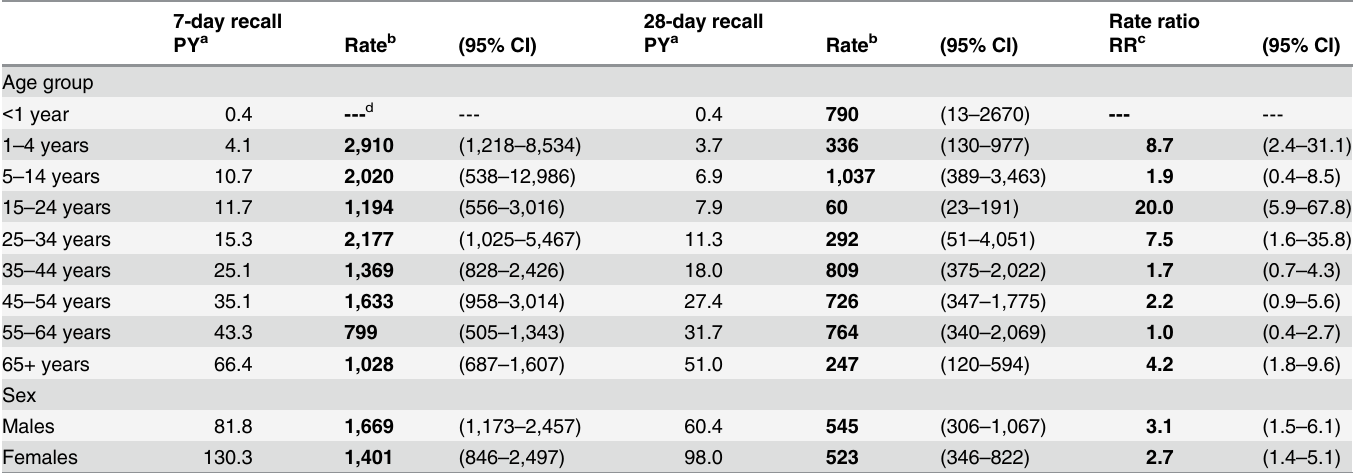
Table 2. Incidence rate of overall IID in the Telephone Survey by recall period, age group and sex. Estimates are standardised by age and sex accord- ing to the UK census population and they are adjusted taking into account different size of the populations in each UK country, prevalence of non-infectious diarrhoea in the population, proportion of time spent outside the UK, and number of interviews completed each month.